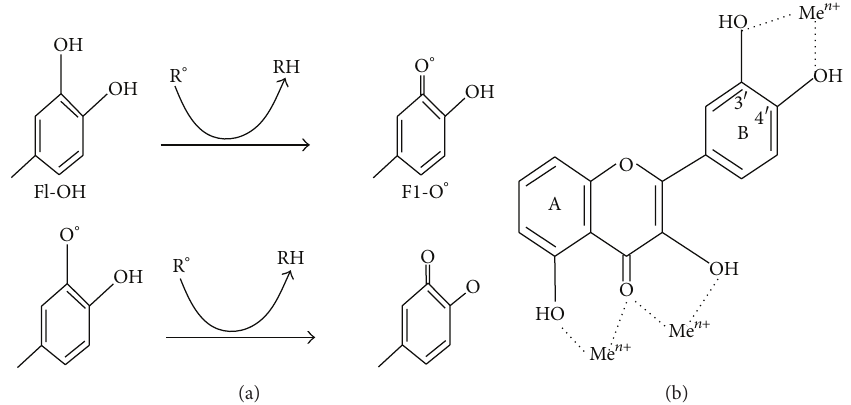
Figure 4: (a) Scavenging of ROS (R ∘ ) by flavonoids (Fl-OH) and (b) binding sites for trace metals where Me 𝑛+ indicates metal ions.